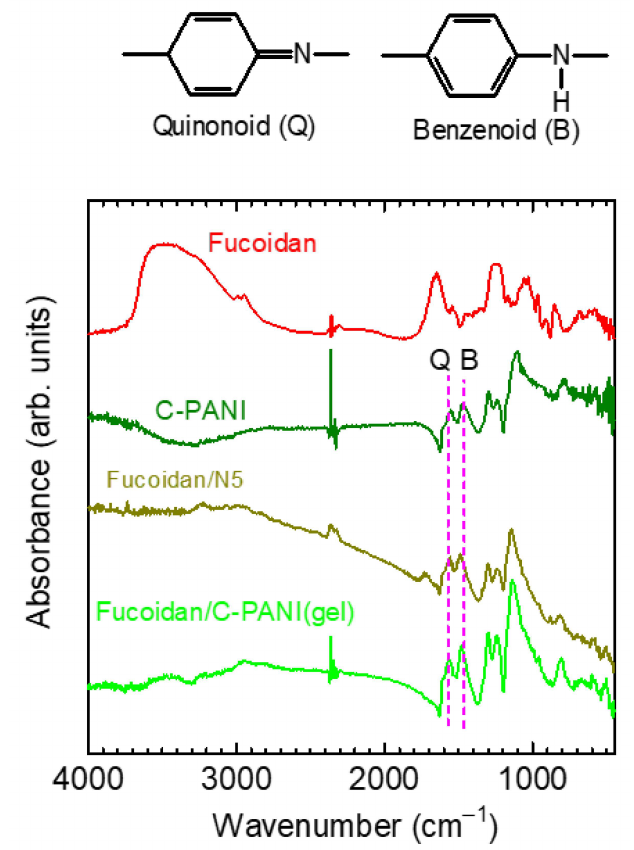
Figure 11. Fourier transform infrared (FT-IR) absorption spectra of fucoidan, C-PANI, fucoidan/N5 prepared by non-gel method, and